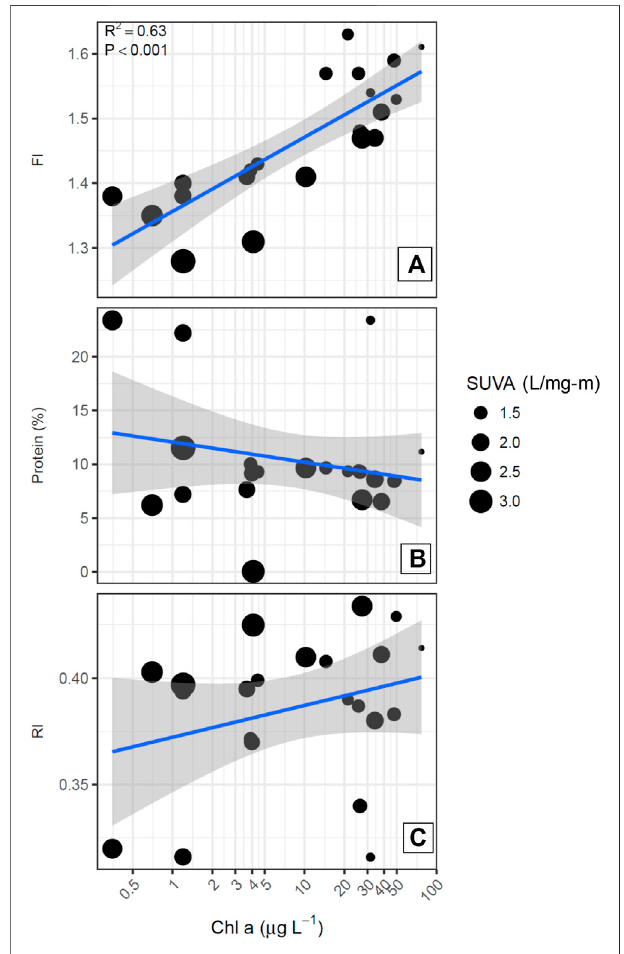
FIGURE 6 | DOM quality metrics plotted as a function of log Chl-a concentrations. Point size corresponds with SUVA 254